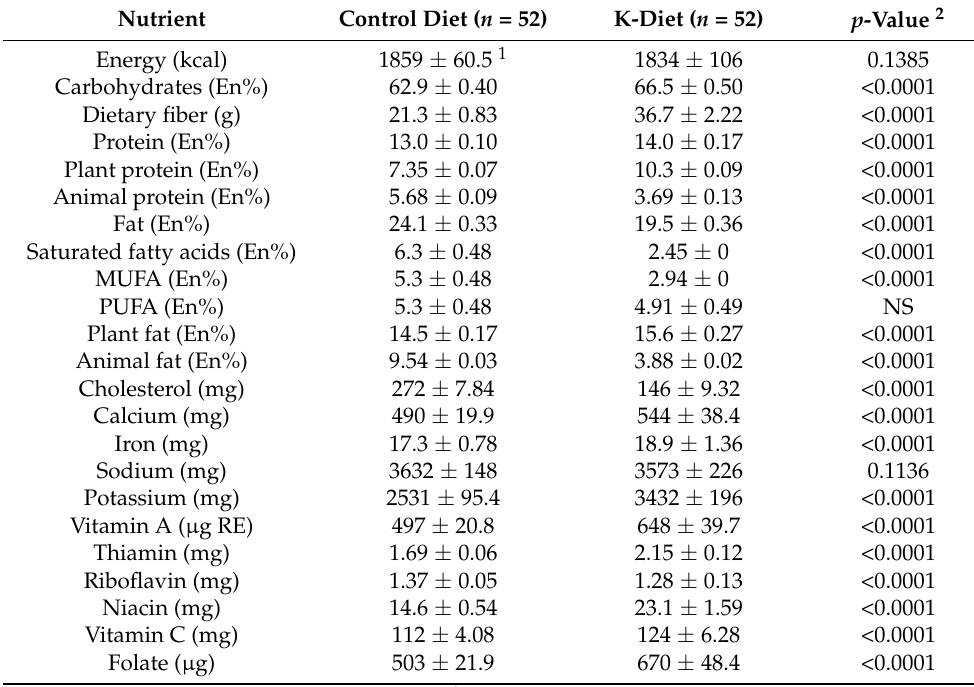
Table 3. Daily nutrient intake during the intervention. Nutrient Control Diet ( n = 52) K-Diet ( n = 52) p -Value